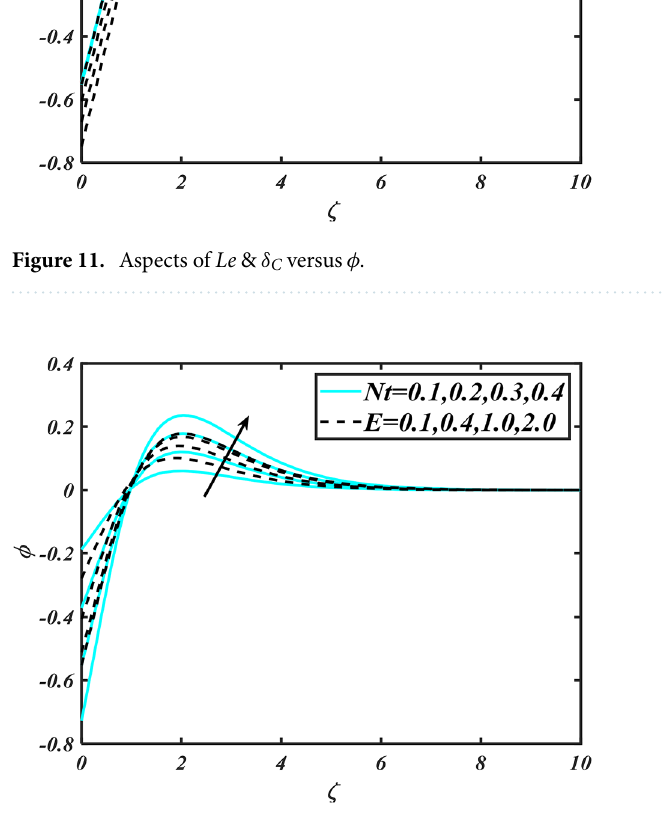
Figure 12. Aspects of Nt & E versus φ